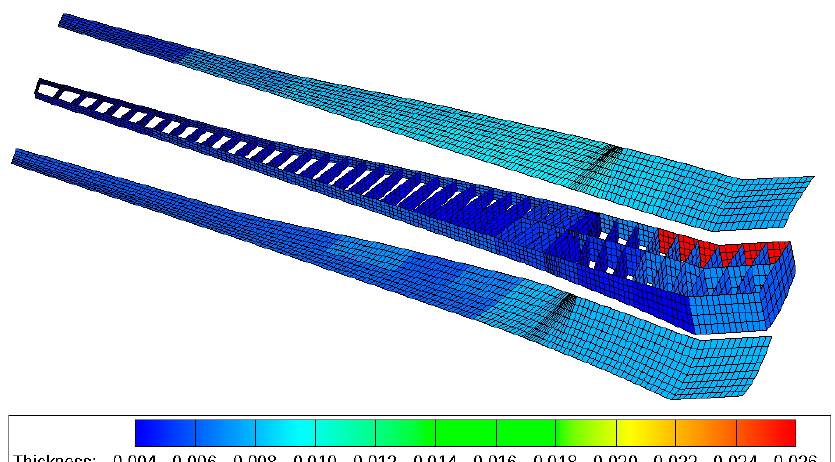
Figure 38. Material thickness distribution in m—red. load factor.